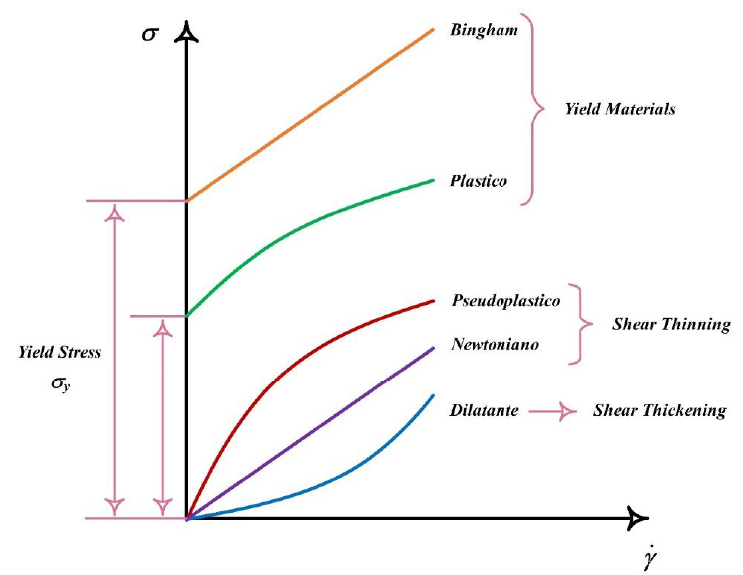
Figure 5. Comparison of non-Newtonian and Newtonian fluids based on their stress and strain variations [69].